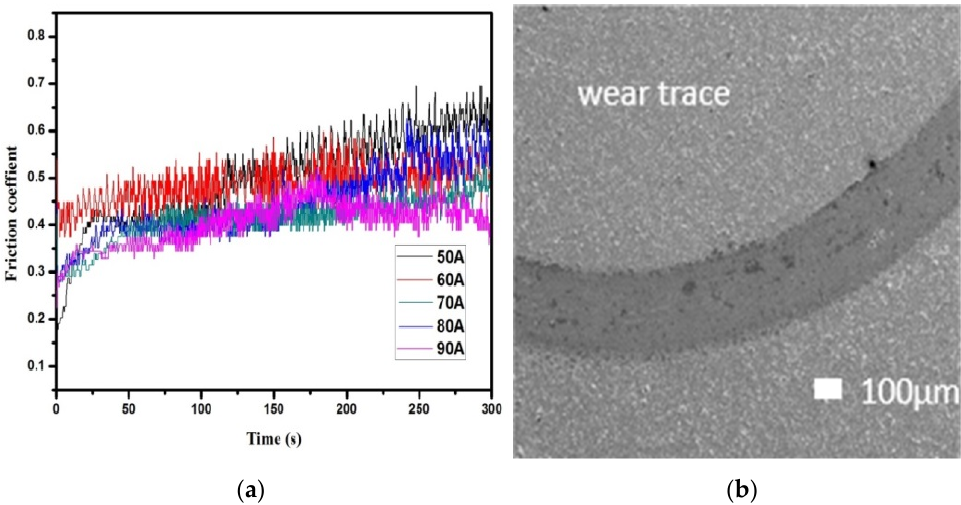
Figure 7. Friction coefficient ( a ) and wear trace ( b ) of CrSiN coatings deposited under different arc currents.